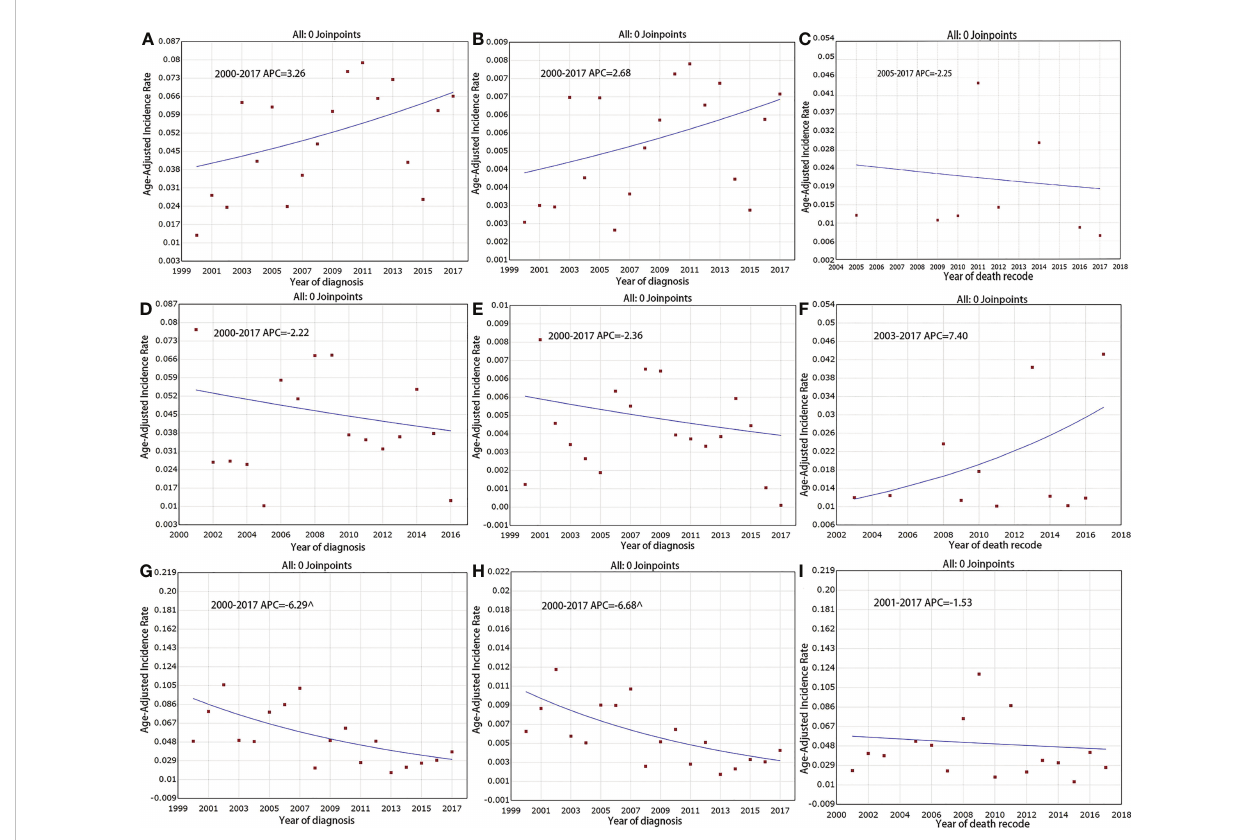
FIGURE 3 Incidence and IB mortality trends of F-PNETs by stage overall 2000 – 2017. (A) Incidence trends of localized disease (Before Imputation). (B) Incidence trends of localized disease (After Imputation). (C) IB mortality trends of localized disease. (D) Incidence trends of regional disease